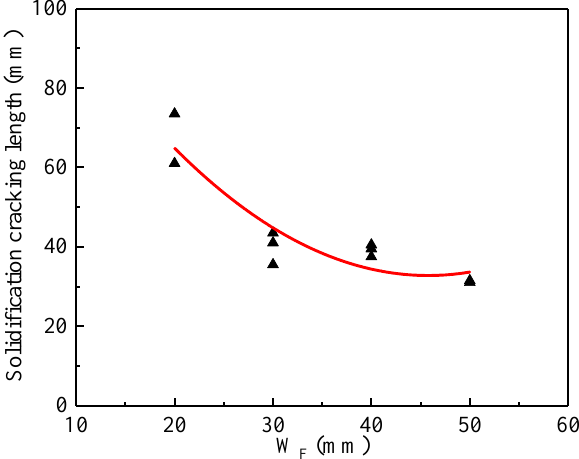
Figure 7. Effect of W F on the solidification cracking length under W S of 12 mm during laser welding at a welding speed of 1.0 m/min.